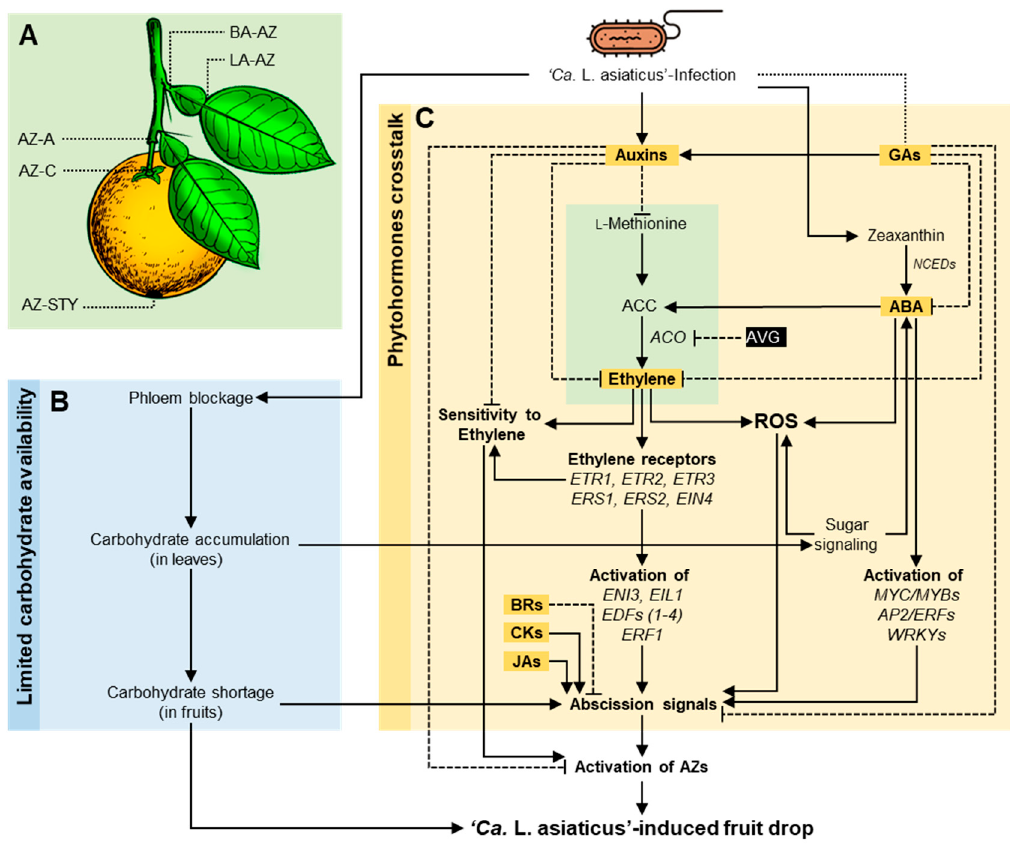
Figure 5. Hypothetical model of the potential roles of citrus phytohormones and carbohydrate availability in the HLB-induced preharvest fruit drop. ( A ) Citrus leaf and fruit abscission zones (AZs). There are five well-defined AZs in citrus. The leaf AZs are located between the shoot and the petiole (BA–AZ; also known as Branch–AZ or Basal–AZ) and between the petiole and the blade (LA–AZ; also known as Laminar–AZ), whereas the fruit AZs are located between the shoot and the peduncle (AZ–A), between the calyx and the fruit itself (AZ–C), and between the fruit and the style (AZ–STY). ( B , C ) Two hypothetical models that discuss the potential role of carbohydrate availability and phytohormone imbalance, respectively, in HLB-induced preharvest fruit drop. Briefly, the first hypothesis is based on that ‘ Ca . L. asiaticus’ infection induces collapse and proliferation of phloem cells and plugging of sieve pores in citrus leaves causing phloem blockage, which could block the carbohydrate flow in the phloem, causing limited carbohydrate availability to the citrus fruits. The second hypothesis was built on the phytohormonal imbalance at the AZs, which might play a key role in the regulation of cell separation processes and, eventually, fruit drop. Several phytohormone groups might be implicated in abscission processes, including auxin and indole derivatives, ethylene and its precursors, abscisic acid (ABA), gibberellins (GAs), cytokinins (CKs), brassinolide (BRs), and jasmonates and their methyl ester (JAs).